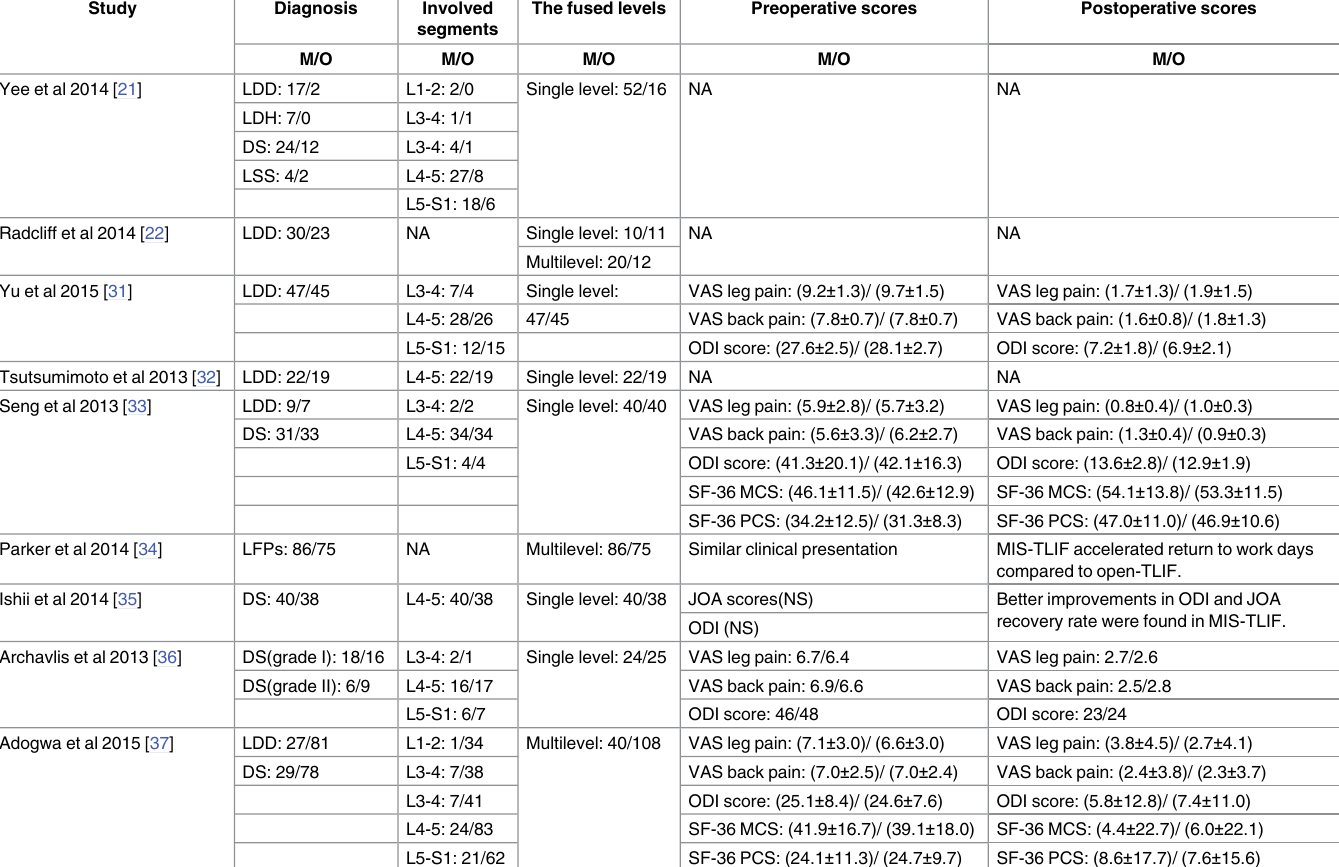
Table 2. The detailed matching information of patients clinical